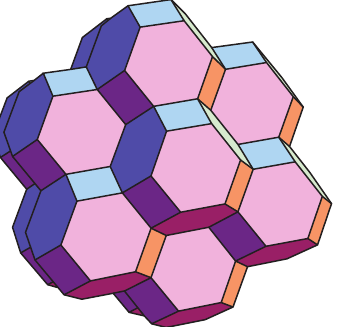
Figure 6. Cluster of 15 truncated octahedra or tetrakaidecahedra, the central polyhedron is surrounded by 14 nearest neighbors. The 9 polyhedra depicted in Figure 5 are joined by 6 polyhedra, which are attached in such a way that they share a square face with the polyhedron located at the center of the BCC cell. Other grains joining this cluster will not have contact with the central grain, which contains the pioneer plate.